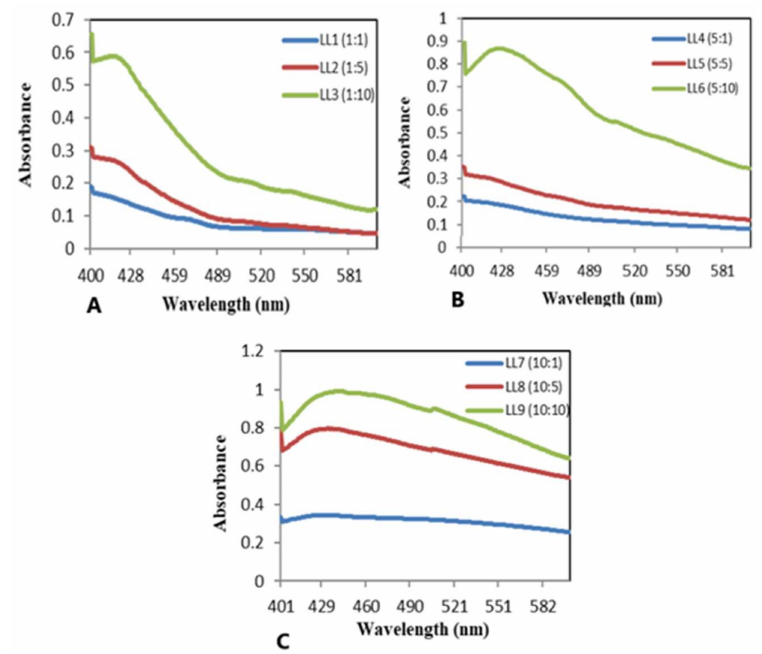
Figure 2. UV–Vis spectra of AgNP with different concentrations of silver nitrate and plant extract: ( A ) Ligustrum lucidum (LL) silver nanoparticles prepared with 1 mM AgNO 3 and 1, 5, and 10 mg mL − 1 of plant extract (LL1, LL2, LL3); ( B ) Ligustrum lucidum (LL) silver nanoparticles prepared with 5 mM AgNO 3 and 1, 5, 10 mg ml -1 of plant extract (LL4, LL5, LL6), ( C ) Ligustrum lucidum (LL) silver nanoparticles prepared with 10 mM AgNO 3 and 1, 5, 10 mg ml -1 of plant extract (LL7, LL8,